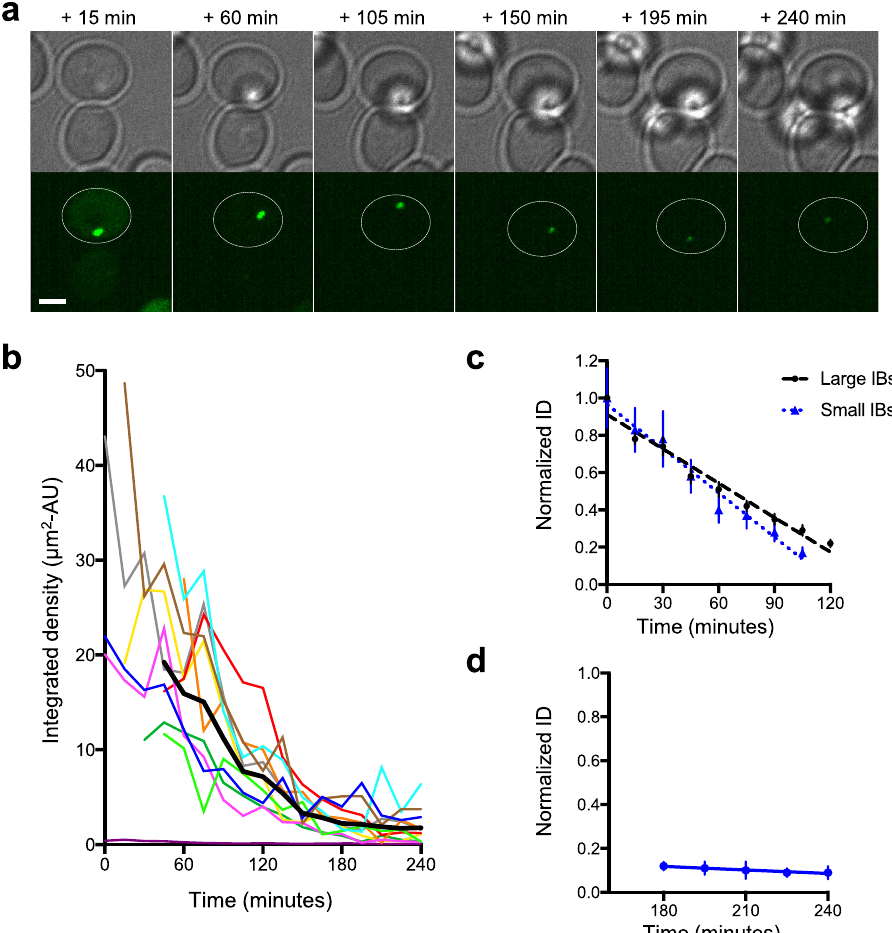
Fig. 5 Biphasic loss of mHtt-GFP from the inclusion body reveals a persistent core. a Bright fi eld (upper panels) and maximum-intensity projections of the GFP channel (lower panels) showing a cell containing a small mHttex1(72Q)-degron-GFP inclusion after the addition of auxin. Time after addition of auxin is shown. The cell containing the inclusion body (IB) is outlined. Scale bar, 2 μ m. b Integrated density was plotted against time for 11 individual small IBs. The thick black line shows the average integrated intensity over time. IB intensities were corrected for bleaching. c The change in integrated density (ID) of small inclusions shown in b is shown for 19 moderate and large (black) and 11 small (blue) inclusions. The rate of decrease in ID is 37% hr − 1 for large IBs ( R 2 = 0.97), and 47%hr − 1 for small IBs ( R 2 = 0.97). Values are corrected for bleaching and normalized to initial IB intensity. d The rate of decrease in the ID of small IBs during the last 75 min of the timecourse is shown (3% hr − 1 , R 2 =